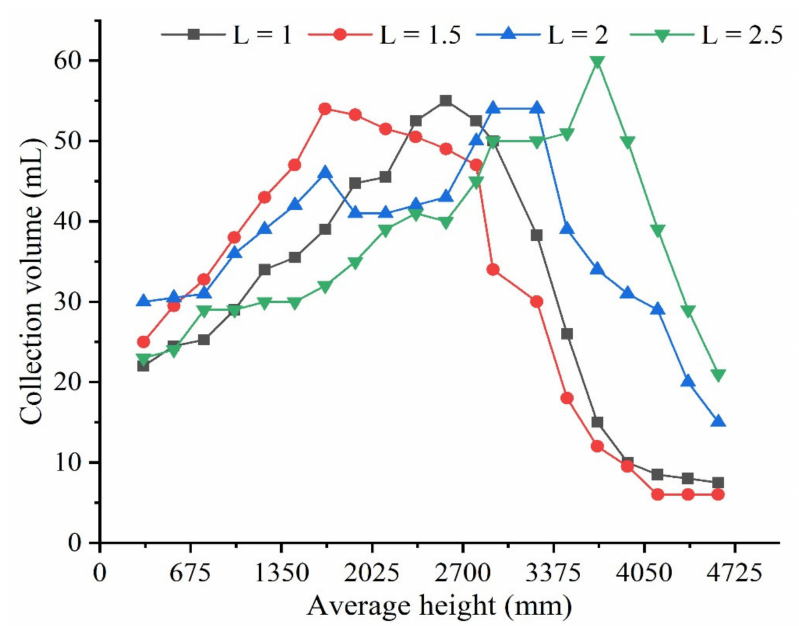
Figure 4. Influence of spray distance on the collection volume (W = 45 ◦ , N = 2400